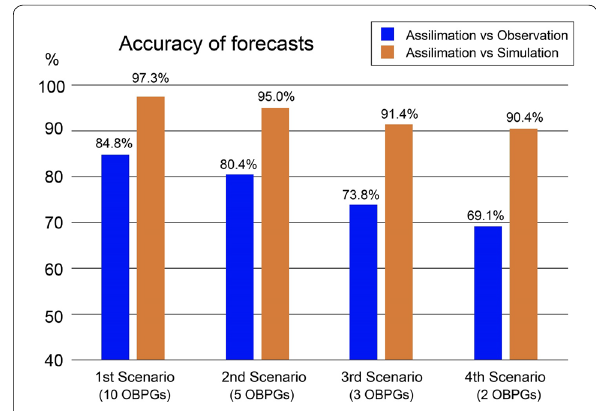
Fig. 8 Performance of different OBPG scenarios in forecasting the 21 May 2003 Mediterranean tsunami. Here, assimilated waveforms are compared with observations (blue) and simulations